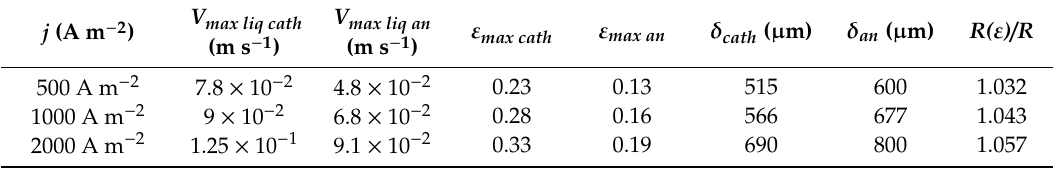
Table 5. Maximum liquid velocity at cathode and anode sides, maximum oxygen and hydrogen void fraction and hydrogen and oxygen diphasic boundary layer for the three